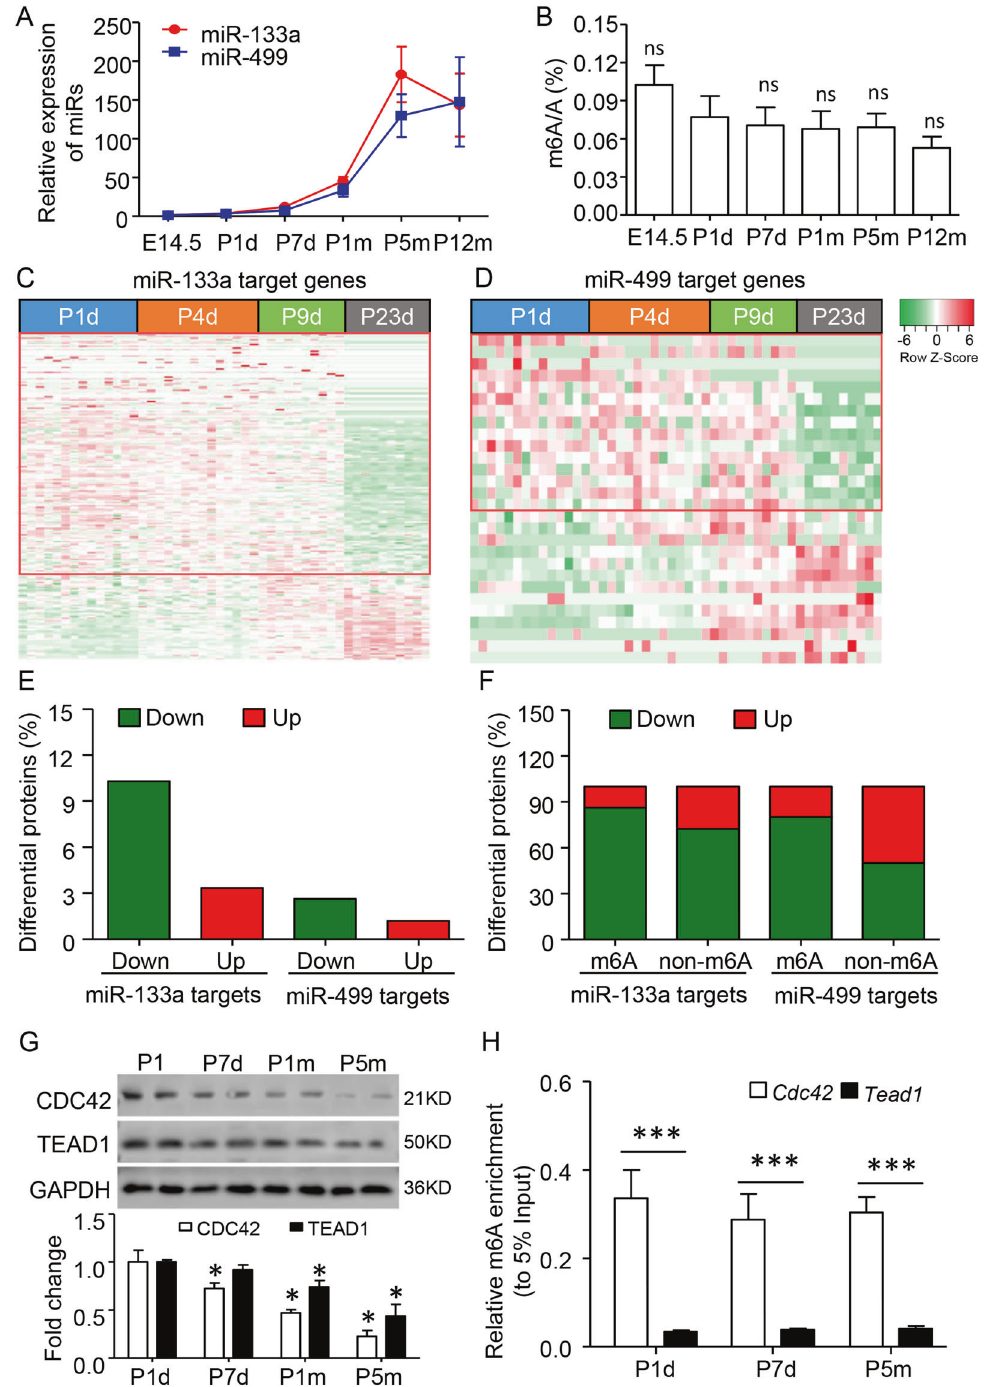
Fig. 2 m6A modi fi cation promotes miR-133a repression in heart development. A Developmental expression pro fi les of miR-133a and miR- 499. The expression changes were calculated by comparing with E14.5 data. B Developmental global m6A modifcation levels, as determined by ELISA analysis. ns, no signi fi cant as compared to P1d. C , D Heatmap showing the developmental changes of miR-133a and miR-499 target protein expression from the published proteomics database. The ventricular tissues were collected from the postnatal day 1 (P1) to P23 of the C57BL/6 mouse. E The percentage of the down- and upregulated proteins (Ratio of P23d to P1d) by miR-133a and miR-499. F The proportions of down- and upregulated genes targeted by two miRs with or without m6A modi fi cation. G Quantitative western blot analysis showed that the decreased CDC42 and TEAD1, two miR-133a target proteins in the developing ventricle from P1d to postnatal 5 months (P5m). Error bars, SD ( n = 4 – 5/stage), * P < 0.05 as compared to P1d. H Enrichment of m6A modi fi cation at Cdc42 and Tead1 was analyzed by m6A-RNA immunoprecipitated-qPCR method. Data are mean ± SD ( n = 4 – 6 per stage). * P < 0.05; *** P < 0.001 was calculated using the one-way ANOVA followed by Tukey ’ s test.